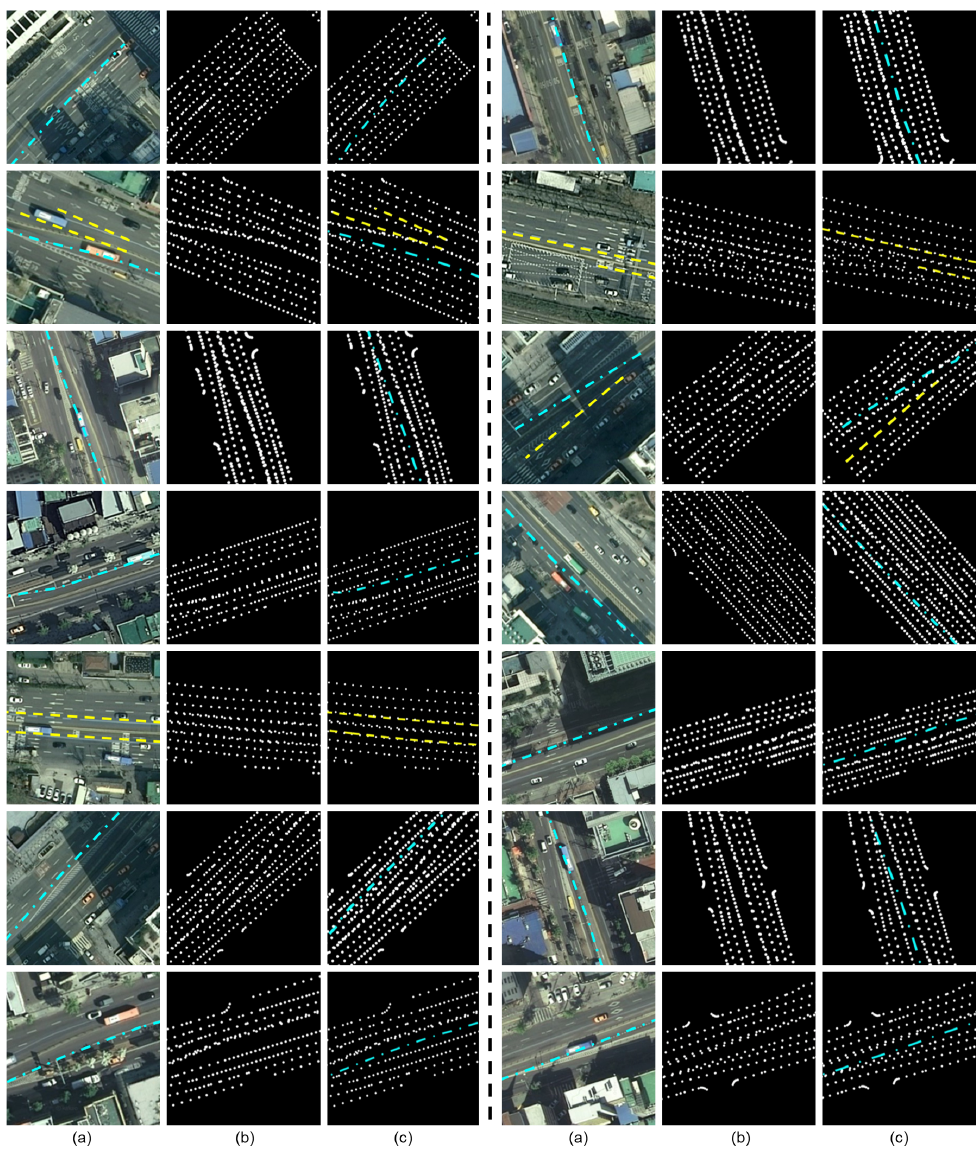
Figure 7. Updated HD maps from five test areas. ( a ) Aerial image. ( b ) HD map before updating. ( c ) Updated HD map. The algorithm automatically detected the changed environments and sug- gested map updates at 45 locations. Finally, a human manager approved 14 updates after manually investigating road images. The presented aerial images may not accurately match HD maps, because many images are outdated. Thus, deleted and newly added lanes are indicated by the yellow dashed and cyan dash-dotted lines, respectively. All HD maps represent different landmark classes with different line styles. Normal , Deleted and New correspond to white dotted, yellow dashed, and cyan dash-dotted lines,